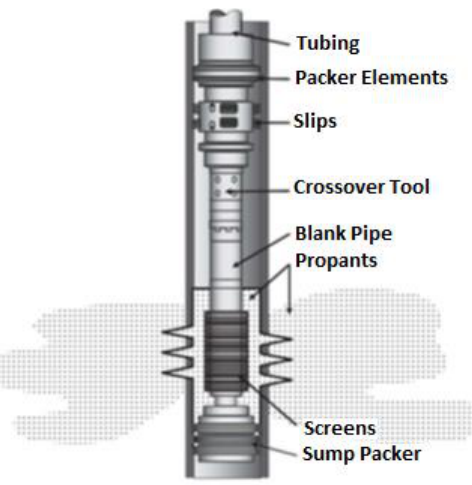
Figure 9. Downhole completion tool for the geothermal application [13].